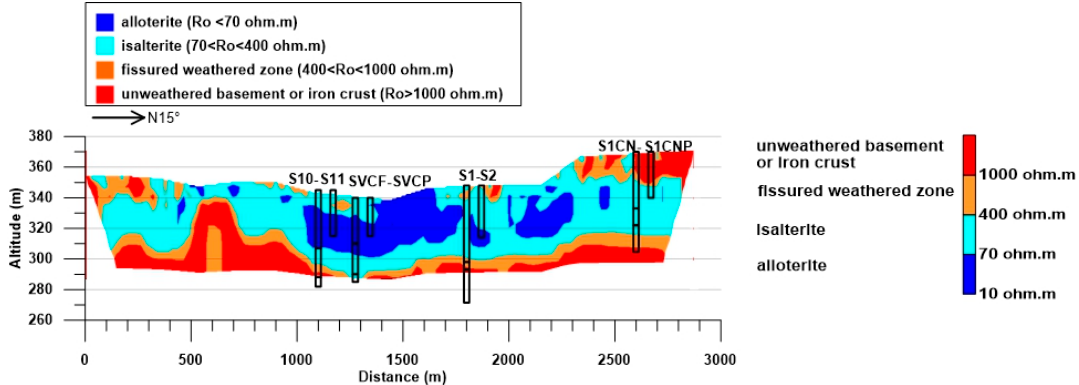
Figure 2. Profile 1: geological model showing different parts (and related electrical resistivity values) of the weathering profile and well-test locations (modified from Soro et al. [8]).